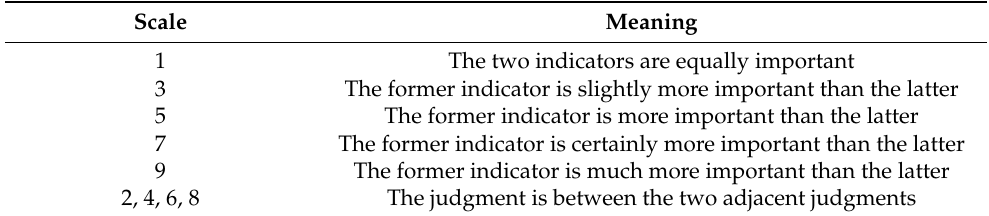
Table 1. Meaning of the scale.